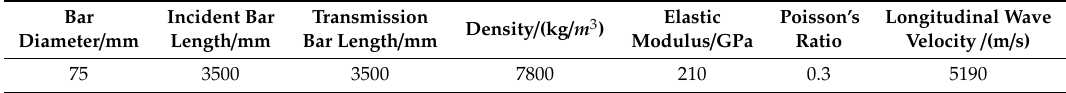
Table 2. Split Hopkinson pressure bar (SHPB) experimental system parameters.